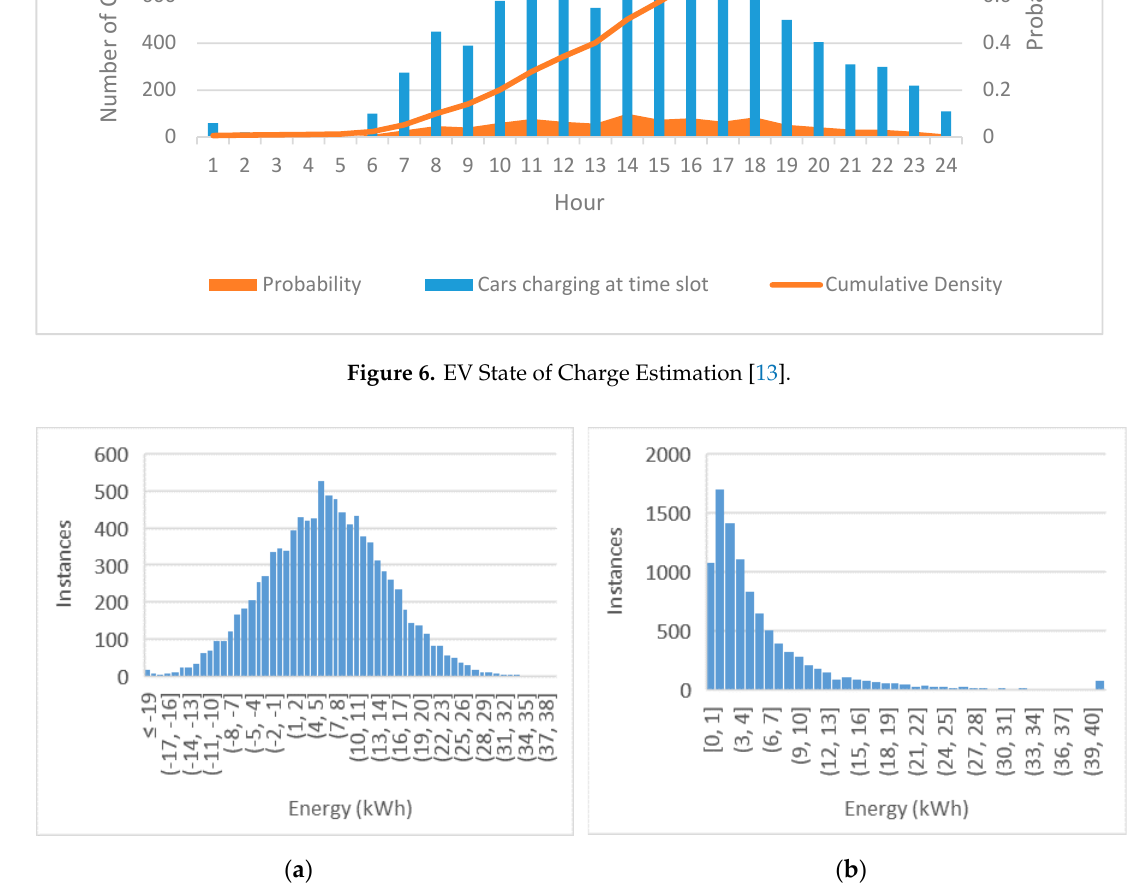
distribution energy requirement per charging instance. energy requirement per charging